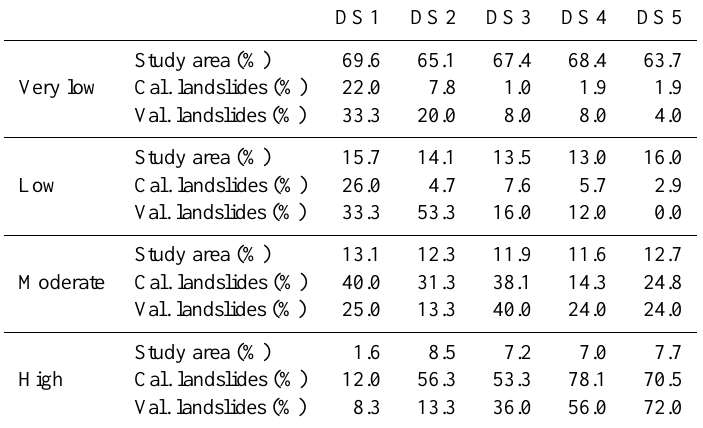
Table 5. Proportion of the study area for each susceptibility class of the obtained susceptibility maps and the respective number of landslides.